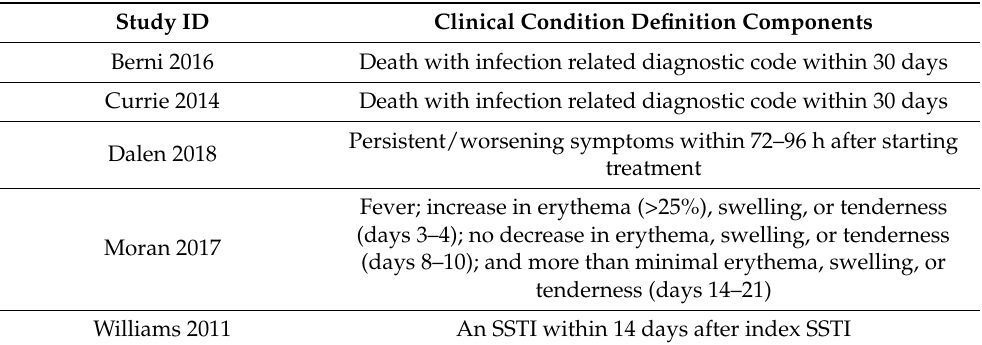
Table 2. Clinical condition definition components used in SSTI studies.